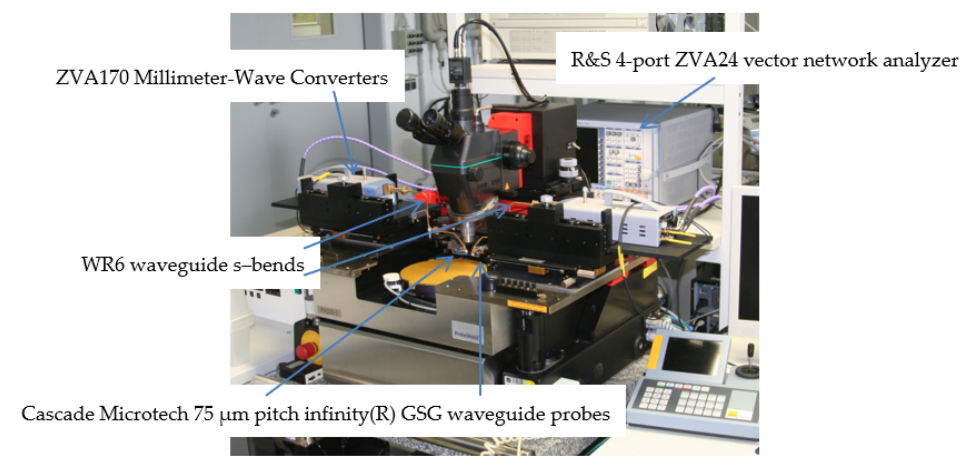
Figure 8. 110–170 GHz S-parameter measurement setup using a semi-automated wafer probe station.